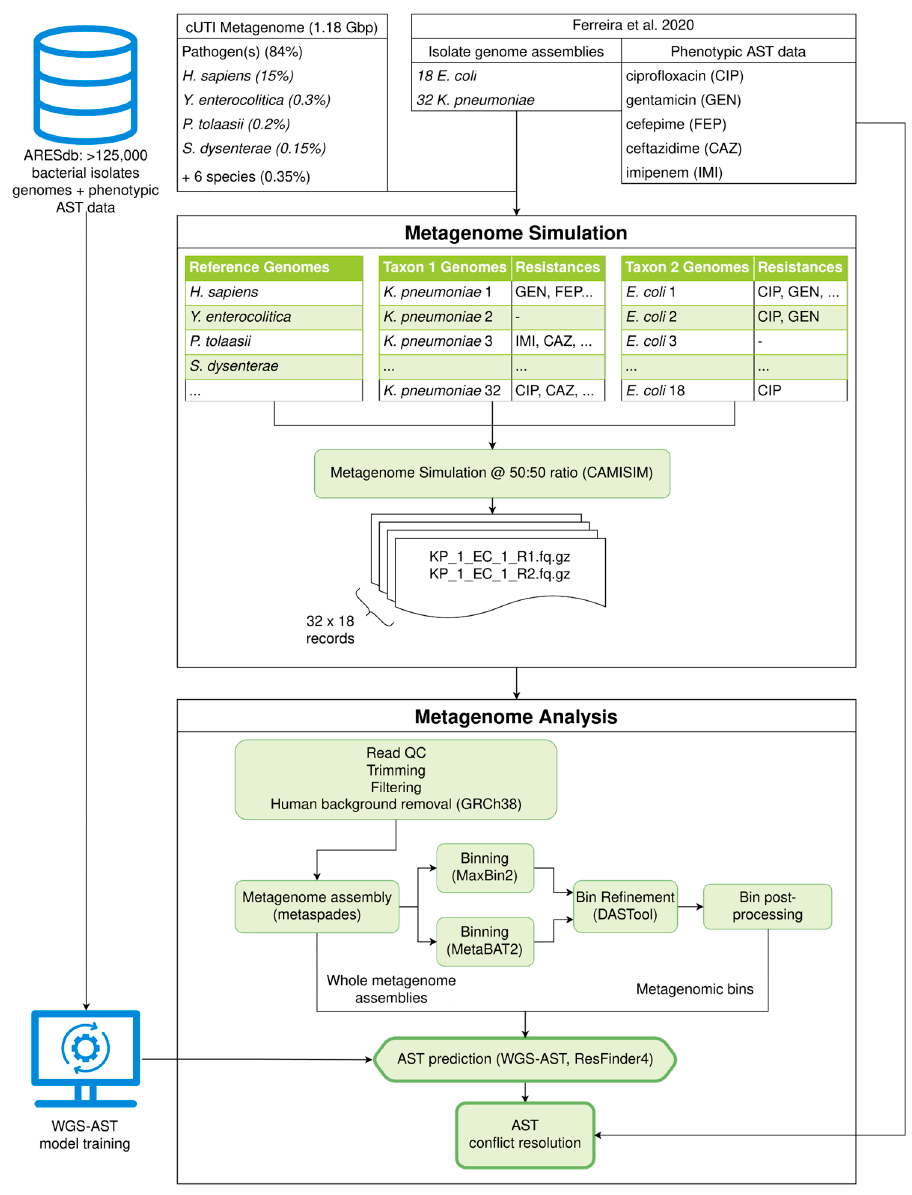
Figure 2. Experimental layout of E. coli/K. pneumoniae co-infection MG-AST experiment, encompass- ing data selection, metagenome simulation, binning, and MG-AST workflow. Genome assemblies and AST data from Ferreira et al. 2020 [10].